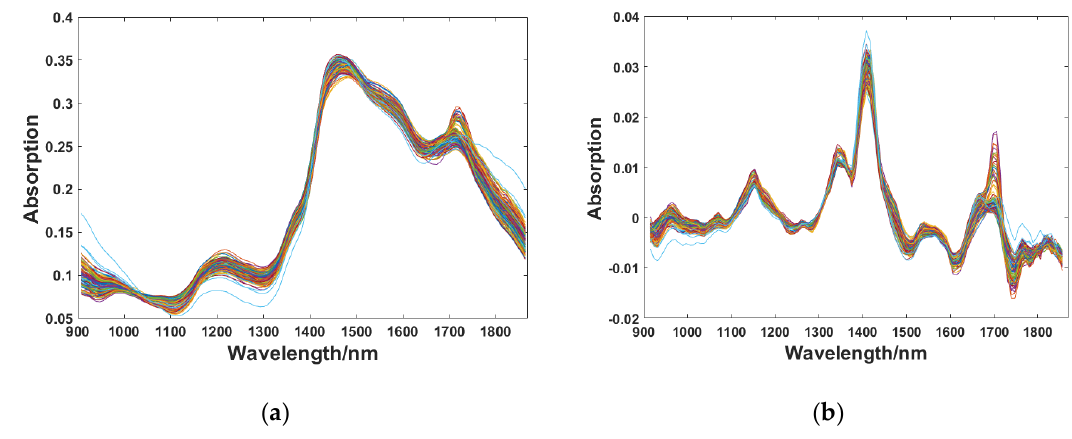
Figure 4. Pretreated spectra: ( a ) Pretreated by MSC; ( b ) Pretreated by MSC combined with SG convolution smoothing and differentiation filter.